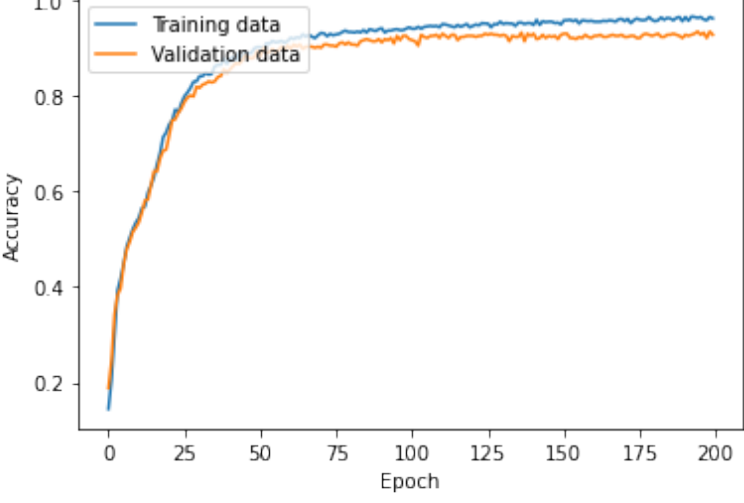
Figure 9. Model ANN(10, 10, 10) Prediction